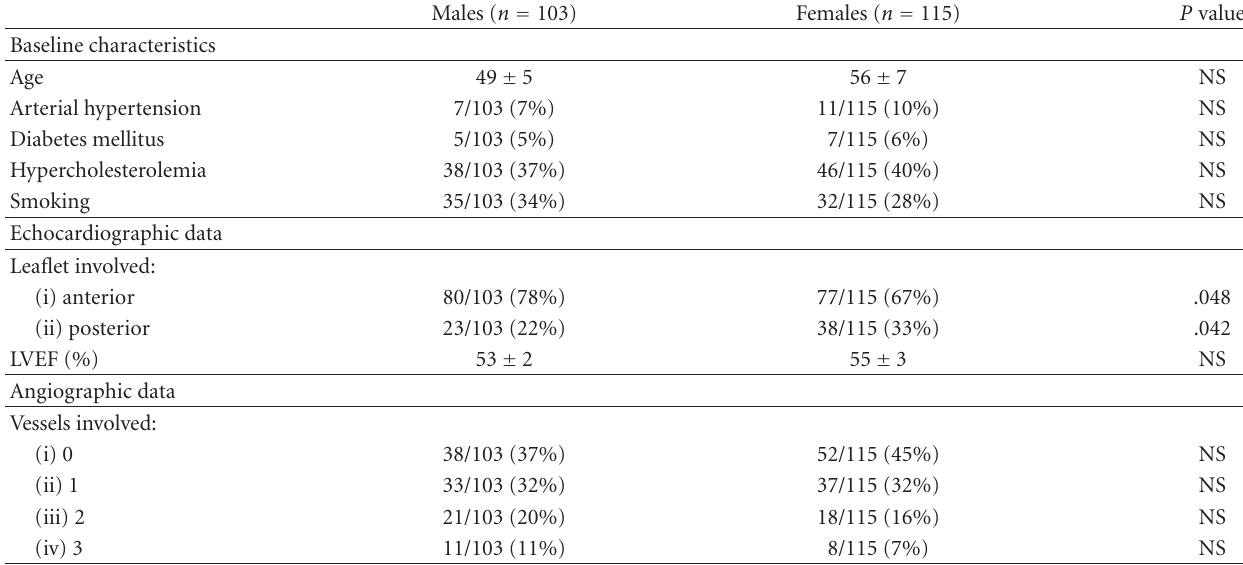
Table 1: Patients characteristics, echocardiographic and angiographic data.